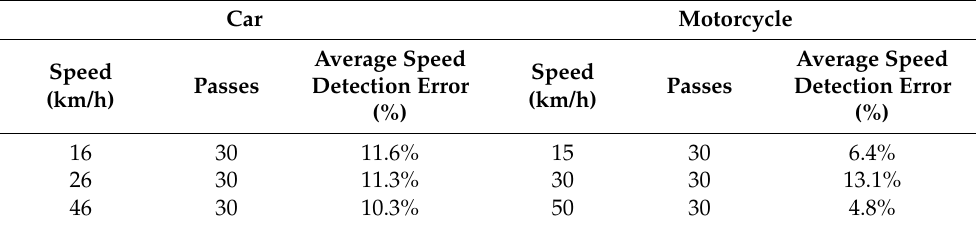
Table 4. Vehicle speed detection